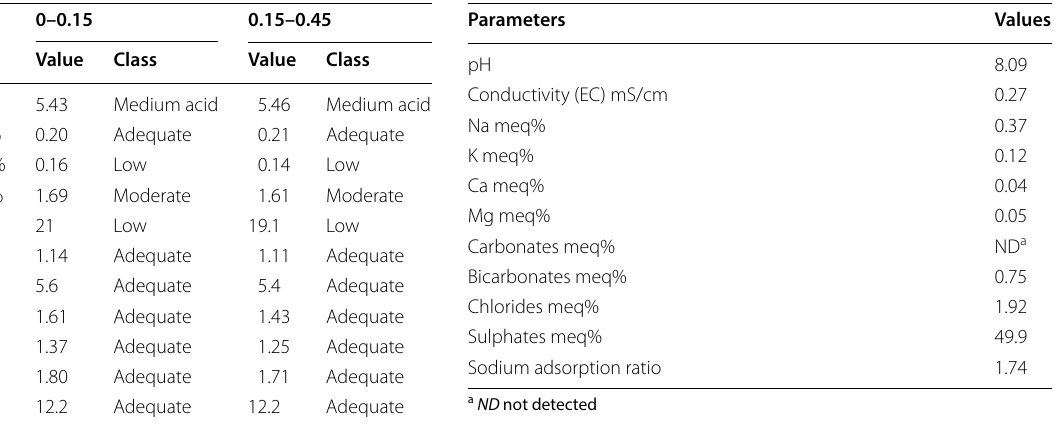
Table. 4 Composition of irrigation water